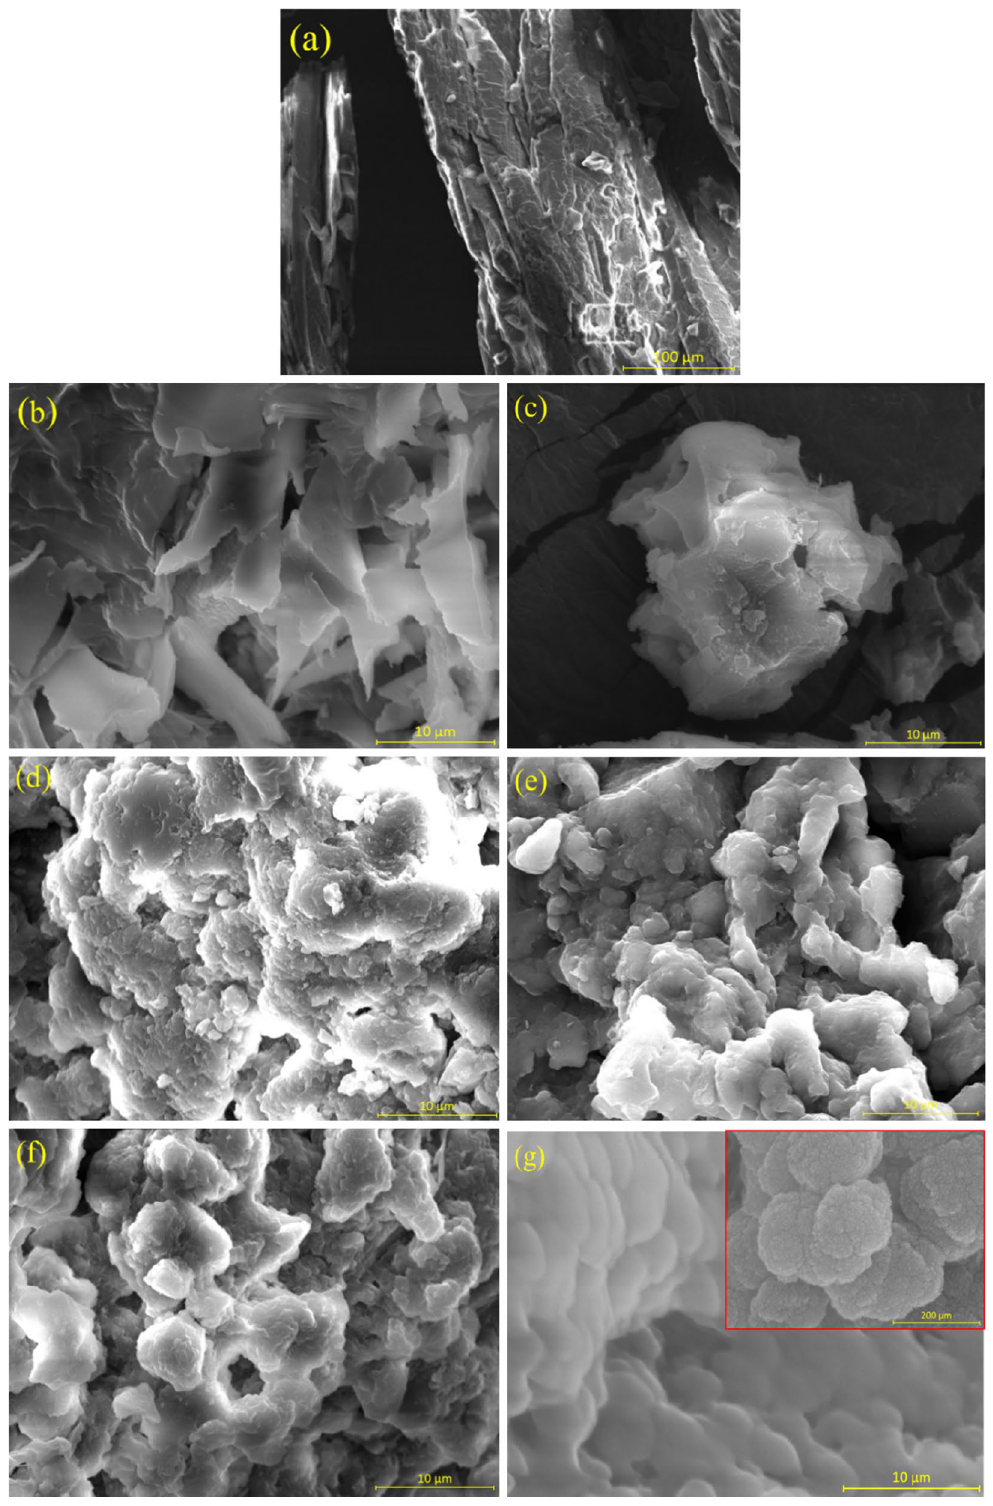
Figure 8. SEM of ( a ) LA, ( b ) LAPC-1, ( c ) LAPC-2, ( d ) LAPC-3, ( e ) LAPC-4, ( f ) LAPC-5 and ( g )